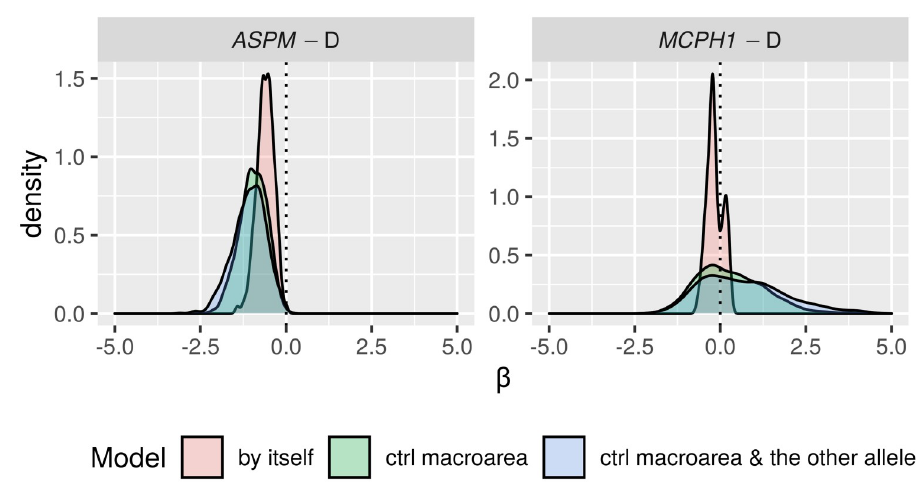
Fig 19. Distribution of the restricted sampling regressions for tone2 . Same conventions as in Fig 10.